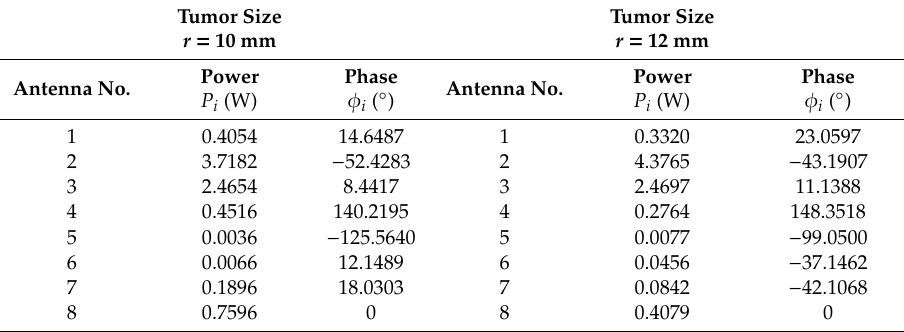
( f ) Figure 7. The distributions of power dissipation ( Q = ρ SAR) in the xy plane for various tumor radii: ( a ) r = 2 mm; ( b ) r = 4 mm; ( c ) r = 6 mm; ( d ) r = 8 mm; ( e ) r = 10 mm; ( f ) r = 12 mm—derived from the eight-dipole antenna array after the optimization procedure (sum P i = 8W).